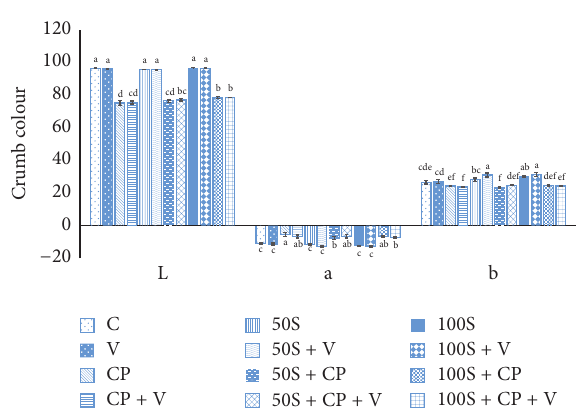
Figure 1: Effect of stevianna without/with cocoa powder and/or vanilla on the crumb colour of muffin. muffins are, from left to right and top to bottom, control (C); vanilla (V); cocoa powder (CP); cocoa + vanilla (CP + V); 50% stevianna (50S); 50% stevianna + vanilla (50S + V); 50% stevianna + cocoa (50S + CP); 50% stevianna + cocoa + vanilla (50S + CP + V); 100% stevianna (100S); 100% stevianna + vanilla (100S + V); 100% stevianna + cocoa (100S + CP); 100% stevianna + cocoa + vanilla (100S + CP + V).